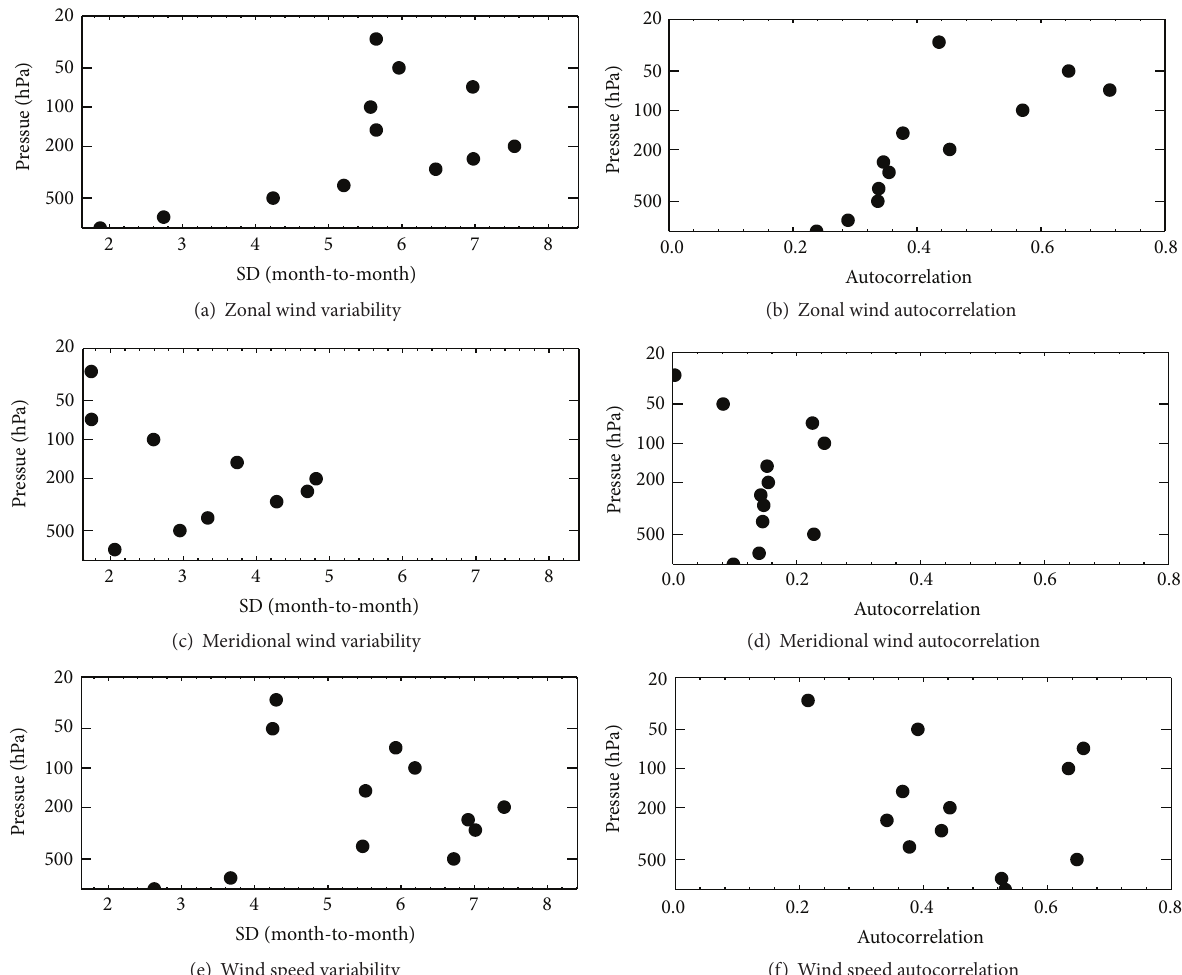
Figure 8: Month-to-month variability and autocorrelation for zonal wind (a, b), meridional wind (c, d), and wind speed (e, f), respectively. The observational data was from 1979 to 2012 for Sterling station Virginia